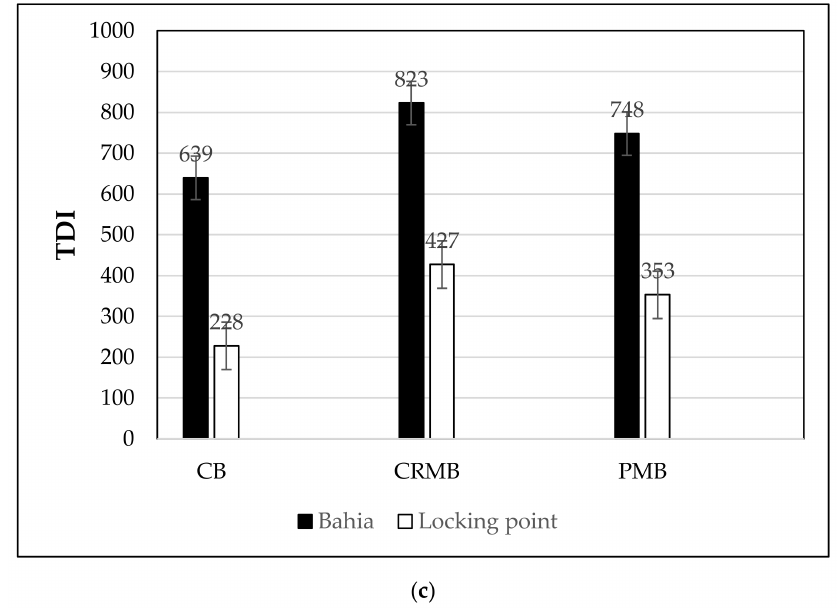
Figure 5. Workability test results: ( a ) number of gyrations, ( b ) Compaction Densification Index (CDI) and ( c ) Tra ffi c Densification Index (TDI)